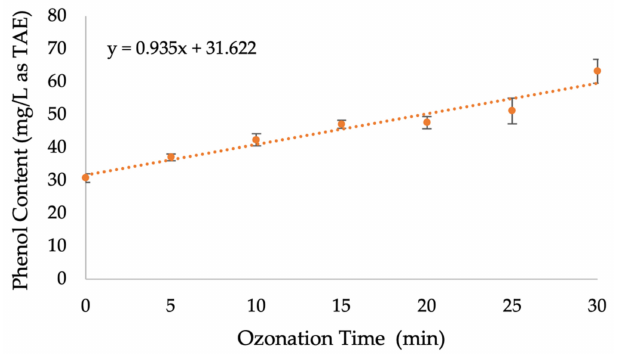
Figure 6. Total phenol content released from RPS during its ozonation